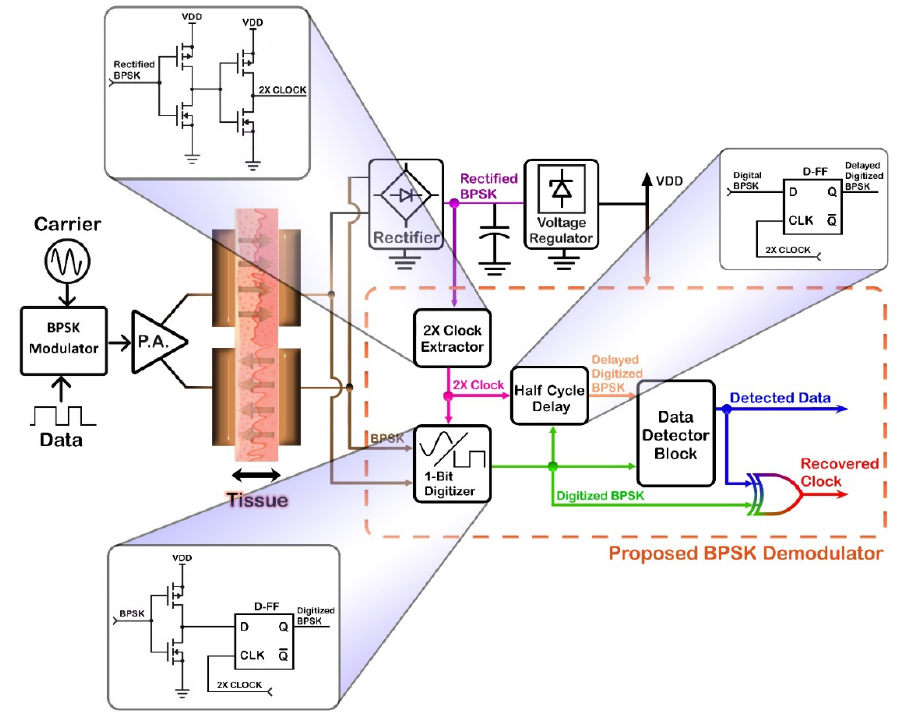
Figure 2. Block diagram of the presented binary phase-shift keying (BPSK) demodulator.